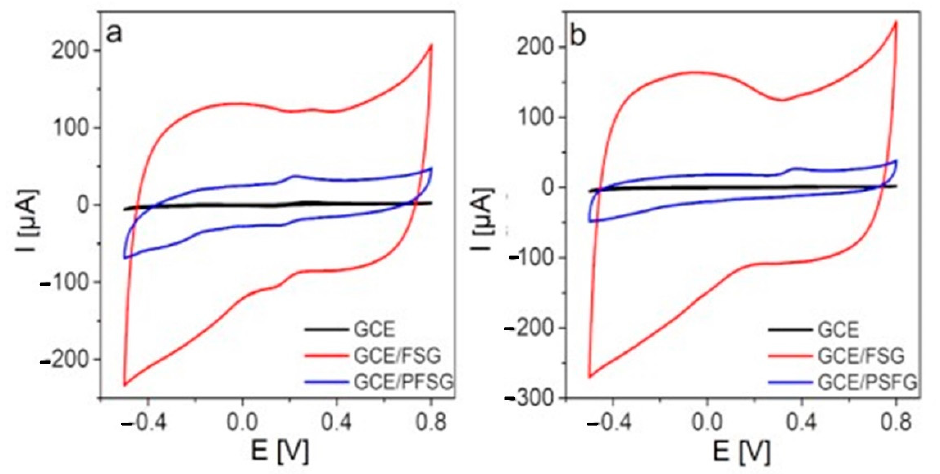
Figure 4. CV curves recorded with the bare GCE, GCE / FSG, GCE / PFSG electrodes in 0.1 M PBS (pH 7.0) containing ( a ) 100 µM DA and ( b ) 300 µM UA.